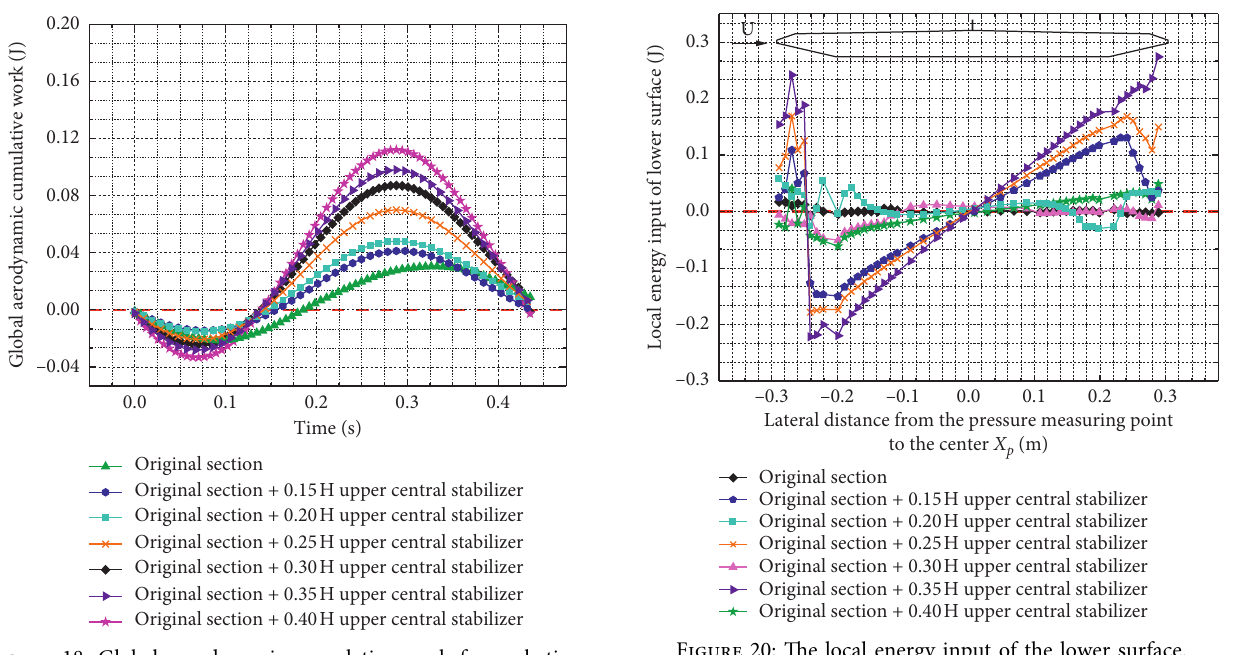
Figure 18: Global aerodynamic cumulative work for each time